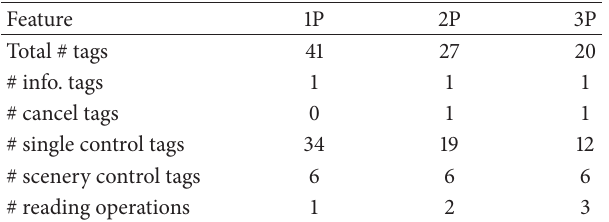
Table 2: Comparison among panel versions: 1P, 2P, and 3P. Table 3: Performance of NFC reader-tag